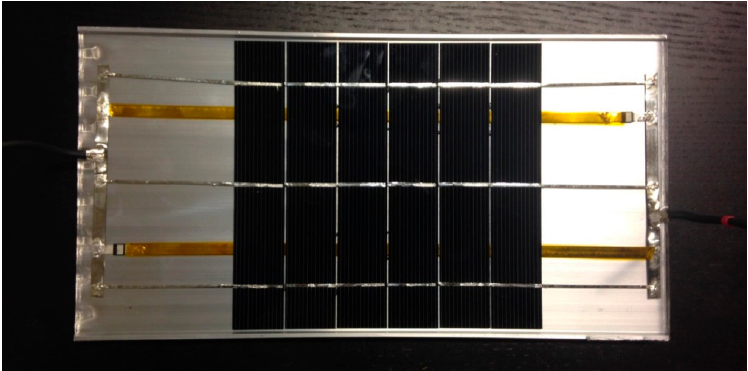
Figure A2. Receiver 2 has six 1/6 cells with a standard cell gap, line soldering, transparent silicon only and no strain relief.